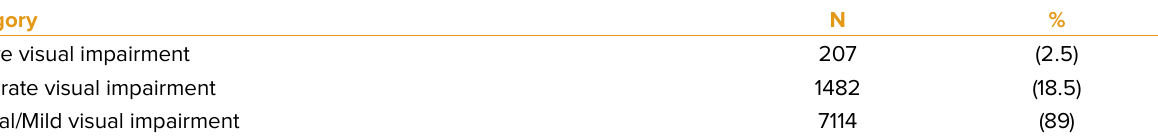
Table 2. Characterization of visual acuity for both eyes in patients aged 50 years and over, Honduras 2018–2019 ( N : 7992)